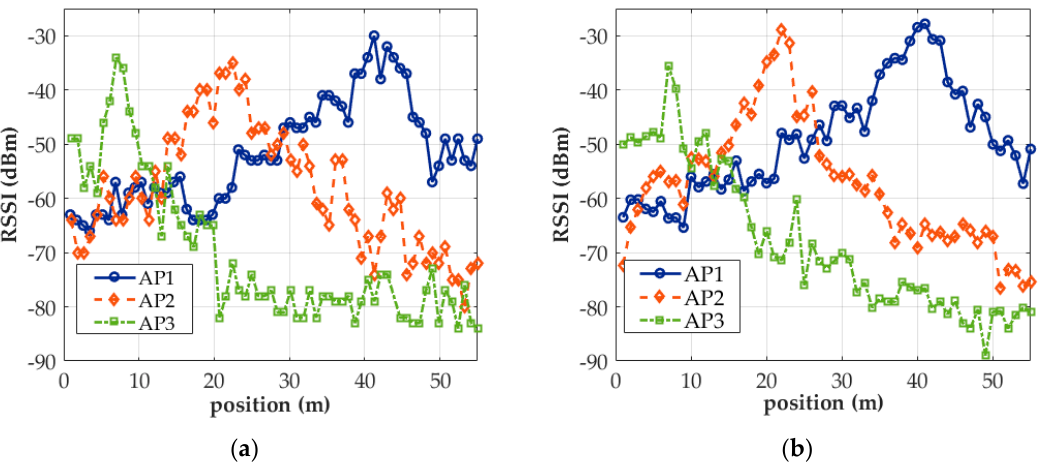
Figure 8. Distribution of AP signals collected: ( a ) through SMS; ( b ) through SS. (at the 2.4-GHz band).